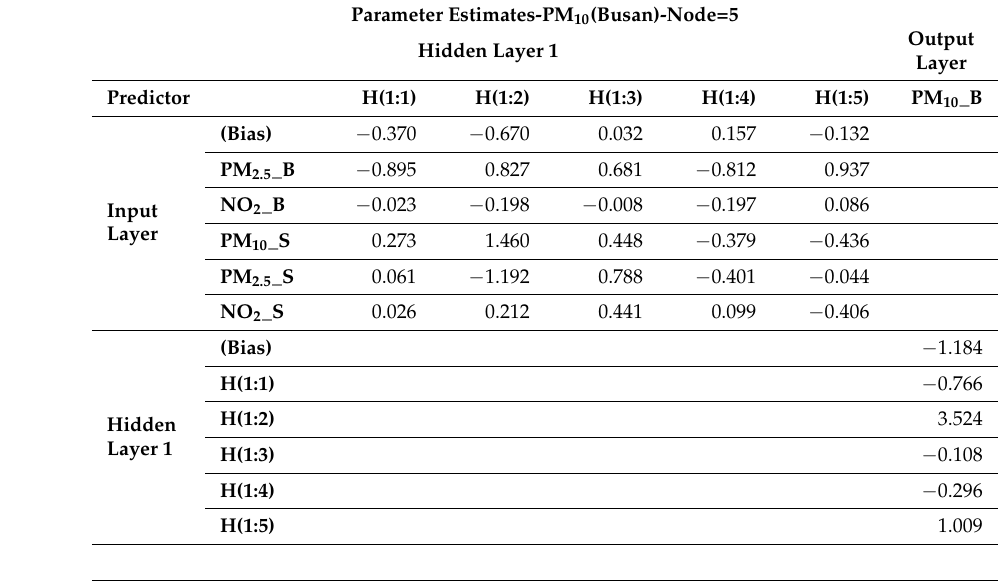
Table 2. As shown in Table 1, except for 5 nodes in a single hidden layer in Seoul and Busan cities. Parameter Estimates-PM 10 (Seoul)-Node=5 Parameter Estimates-PM 10